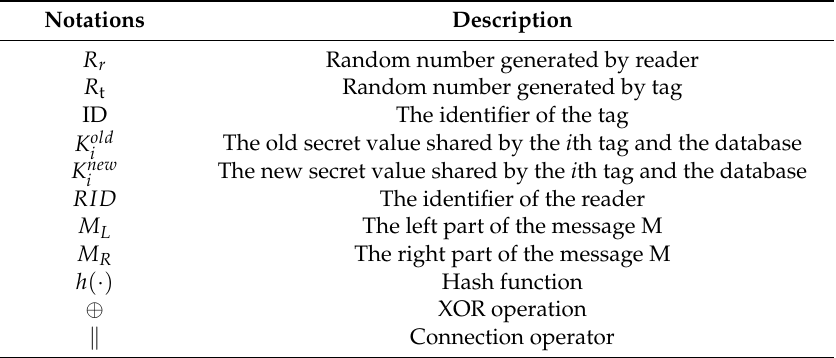
Table 1. The description of notations.